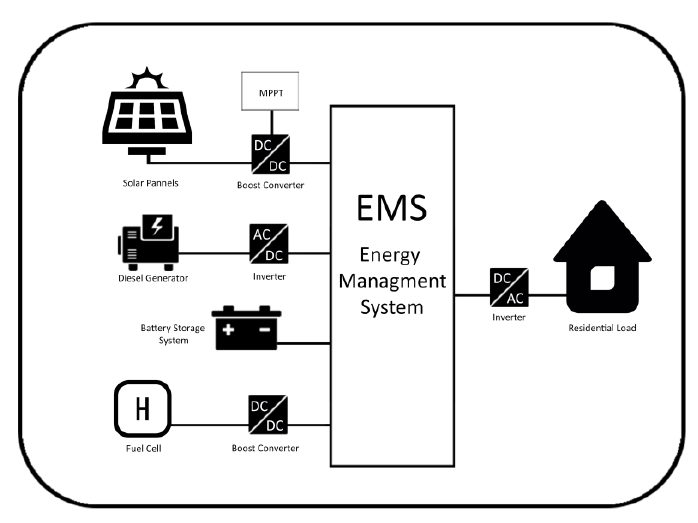
Figure 7. Structure of the microgrid in the second stage.